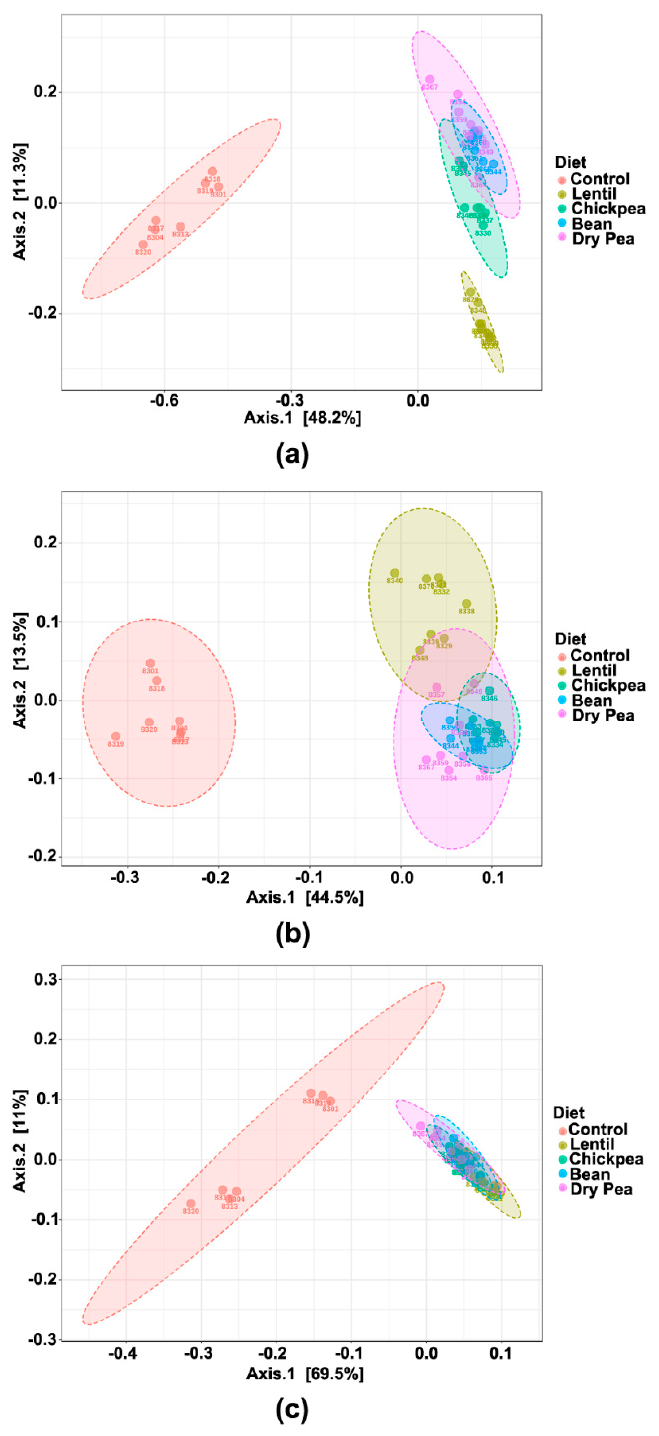
Figure 4. Measures of β -diversity across the diet groups at the ASVs level plotted in the Principal component analysis (PCoA) in 2D. Axes 1 and 2 represented principal components 1 (PC1) and 2 (PC2), respectively. Samples are colored and grouped into ellipses by their corresponding diet group. Differences in the β -diversity were tested by the permutational multivariate analysis of variance using distance matrices (PERMANOVA): ( a ) Bray-Curtis distances were used to explain β -diversity across diet groups. PERMANOVA F -value = 16.312; R 2 = 0.67792; p -value < 0.001; ( b ) Unweighted UniFrac distances were used to explain β -diversity across diet groups. PERMANOVA F -value = 13.642; R 2 =0.63772; p -value < 0.001; ( c ) Weighted UniFrac distances were used to explain β -diversity across diet groups. PERMANOVA F -value = 20.808; R 2 =0.72862; p -value < 0.001.